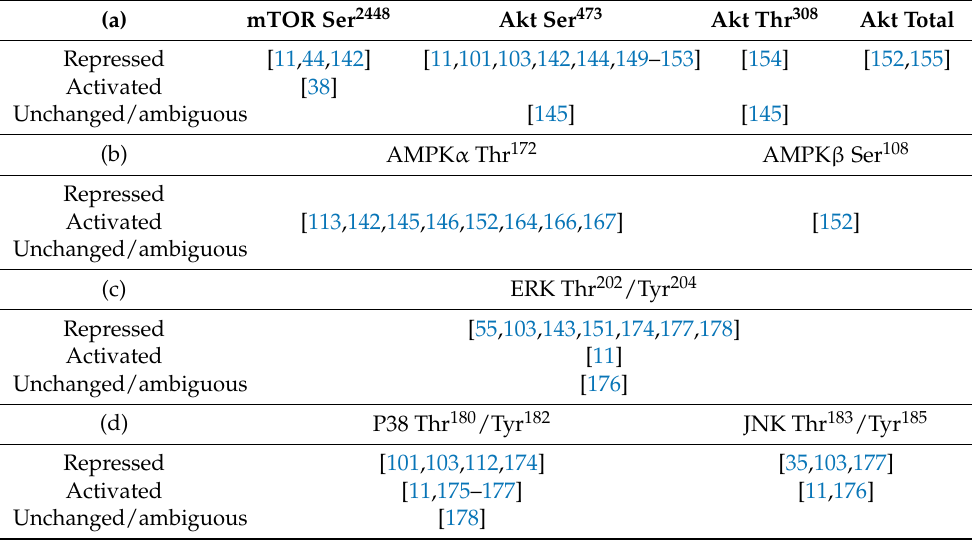
Table 1. Overview of the included publications on signal transduction: ( a ) PI3K/Akt/mTOR; ( b ) AMPK; ( c ) ERK; ( d ) P38, JNK and MAPK signal transduction